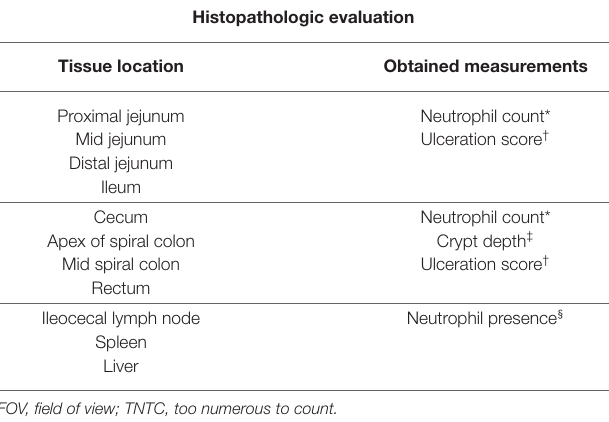
TABLE 1 | Summary of histopathologic measurements obtained from each of the evaluated tissue sections during all three animal